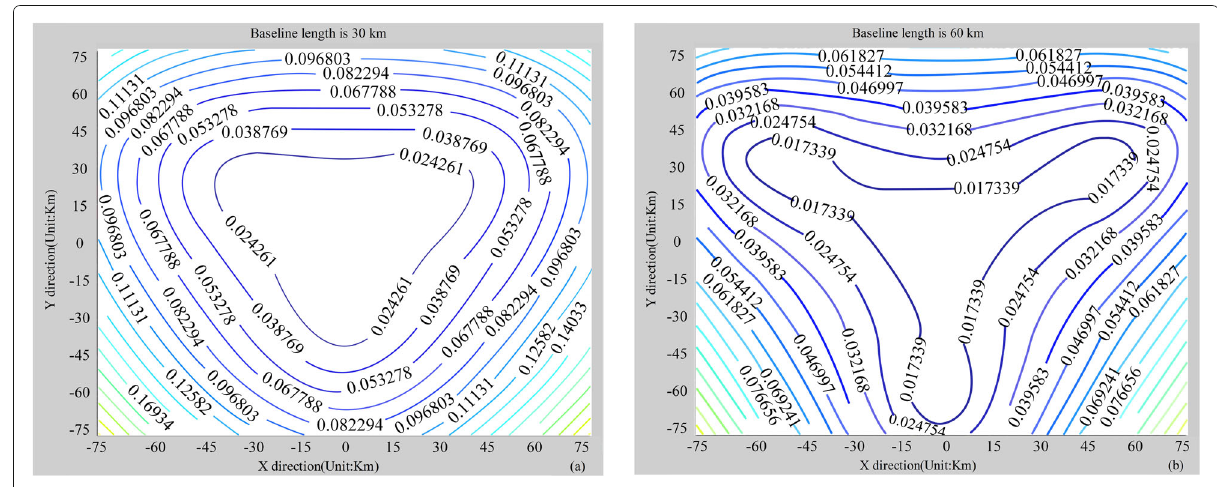
Fig. 3 Influence of baseline length to positioning accuracy